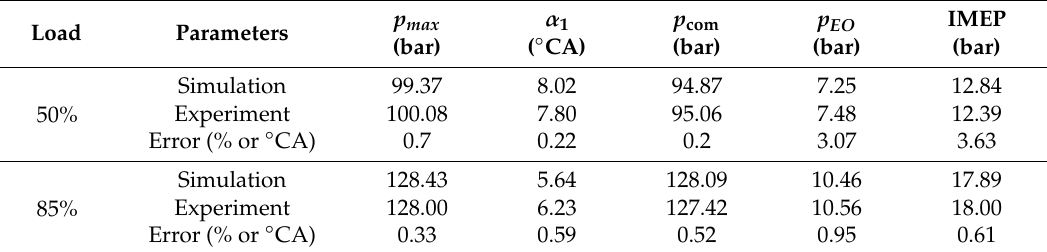
Table 7. Comparison between the simulation and experimental results for the Engine